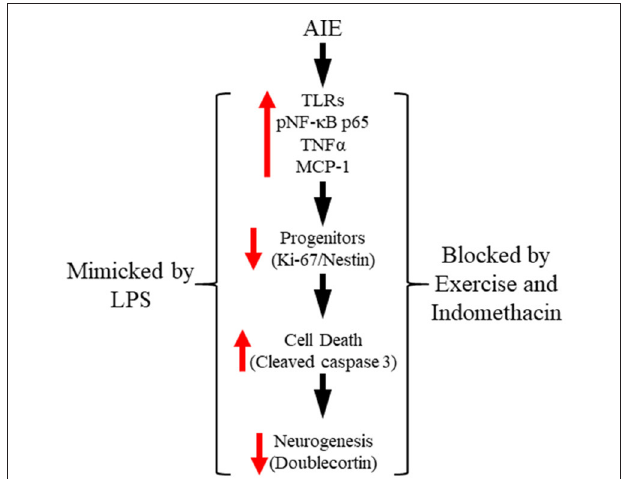
FIGURE 9 | Proposed mechanism of adolescent intermittent ethanol (AIE)-induced loss of hippocampal neurogenesis. Adolescent binge ethanol exposure upregulations Toll-like receptor (TLR) expression in the hippocampus resulting in increased phosphorylation of the proinflammatory transcription factor nuclear factor kappa-light-chain-enhancer of activated B cells p65 (phosphorylated [pNF- κ B p65]). This in turn results in the induction of neuroimmune signaling molecules, including tumor necrosis factor alpha (TNF α ) that activate positive loops of amplification that persist into adulthood ( Crews and Vetreno, 2016). The persistent proinflammatory neuroimmune induction results in diminished neurogenesis and increased cell death that persists into adulthood. Importantly, exposure to either voluntary wheel running, which conveys immune-modulatory effects, or treatment with the anti-inflammatory drug indomethacin restores hippocampal neurogenesis by preventing the AIE-induced increase of cell death (i.e., cleaved caspase 3) as well as increased phosphorylation of pNF- κ B p65. Moreover, treatment with the endotoxin lipopolysaccharide (LPS) mimicked the AIE-induced loss of neurogenesis while increasing expression of cleaved caspase 3 and pNF- κ B p65. Together, these data suggest that increased expression of neuroimmune molecules increases cell death in the hippocampus resulting in the persistent AIE-induced loss of